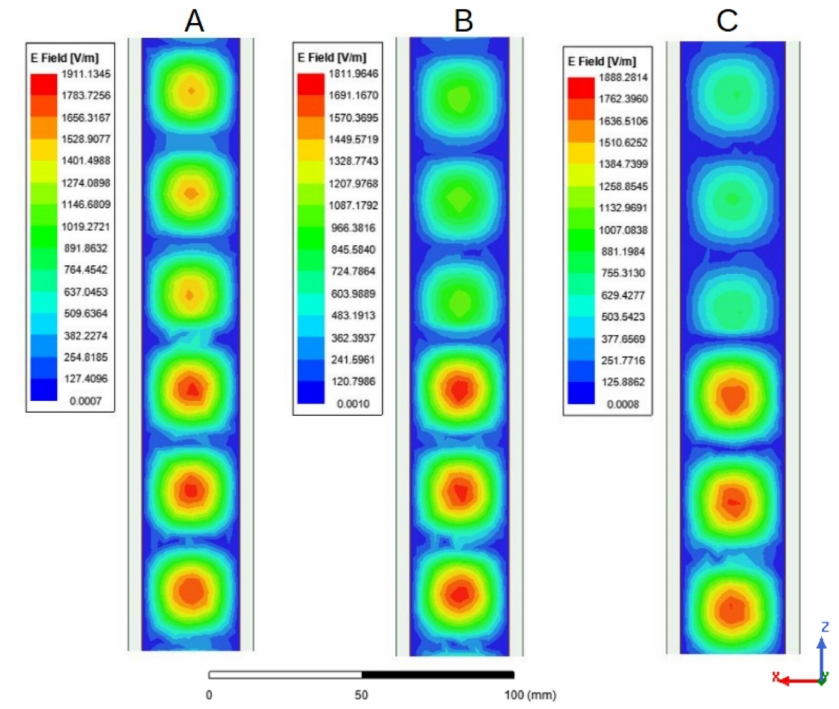
Figure 12. Electric field intensity distribution (ANSYS HFSS) in the WR-137 waveguide fragment, in TE10 mode for 6GHz, in front of and behind a PAN fabric barrier covered with 1 PPy layer ( A ), 3 PPy layers ( B ) and 5 layers of PPy ( C